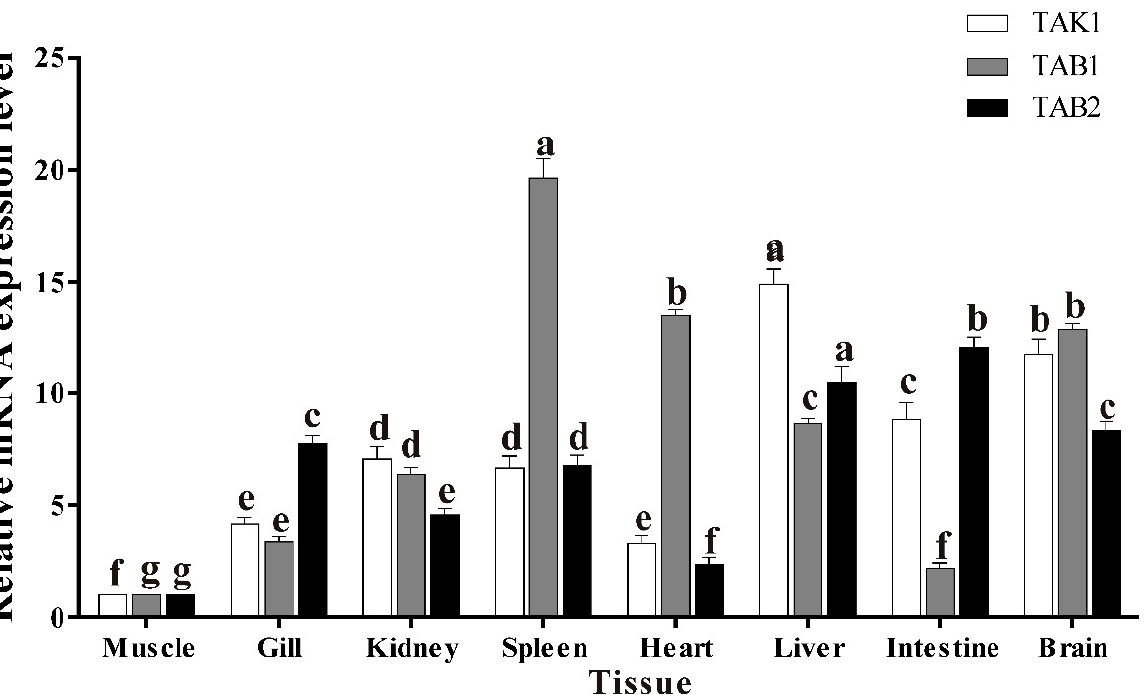
Figure 8. Expression patterns of trTAK1, trTAB1 and trTAB2 in tissues of healthy golden pompano. The expression values were normalized to β -actin, and the data were expressed as mean ± SE. The expression level in muscle was set to 1.0 as control. Bars that do not share a letter represent a significant difference ( p < 0.05) of the same gene among different tissues.